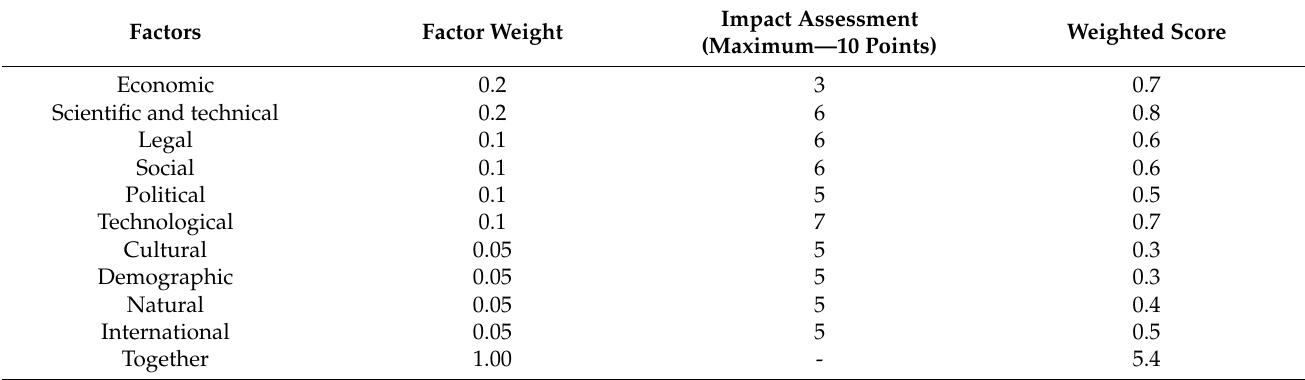
Table 1. Analysis of the influence of macroenvironmental factors on the activities of PJSC “NOVATEK”.